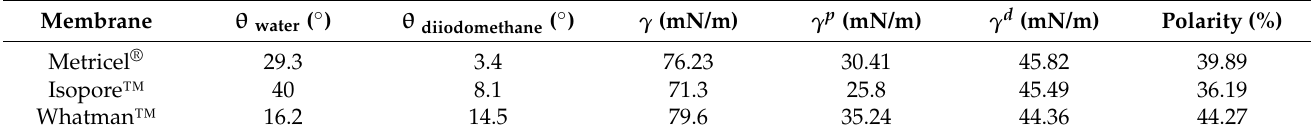
Table 3. Contact angles, surface free energy, and polarity of membranes.